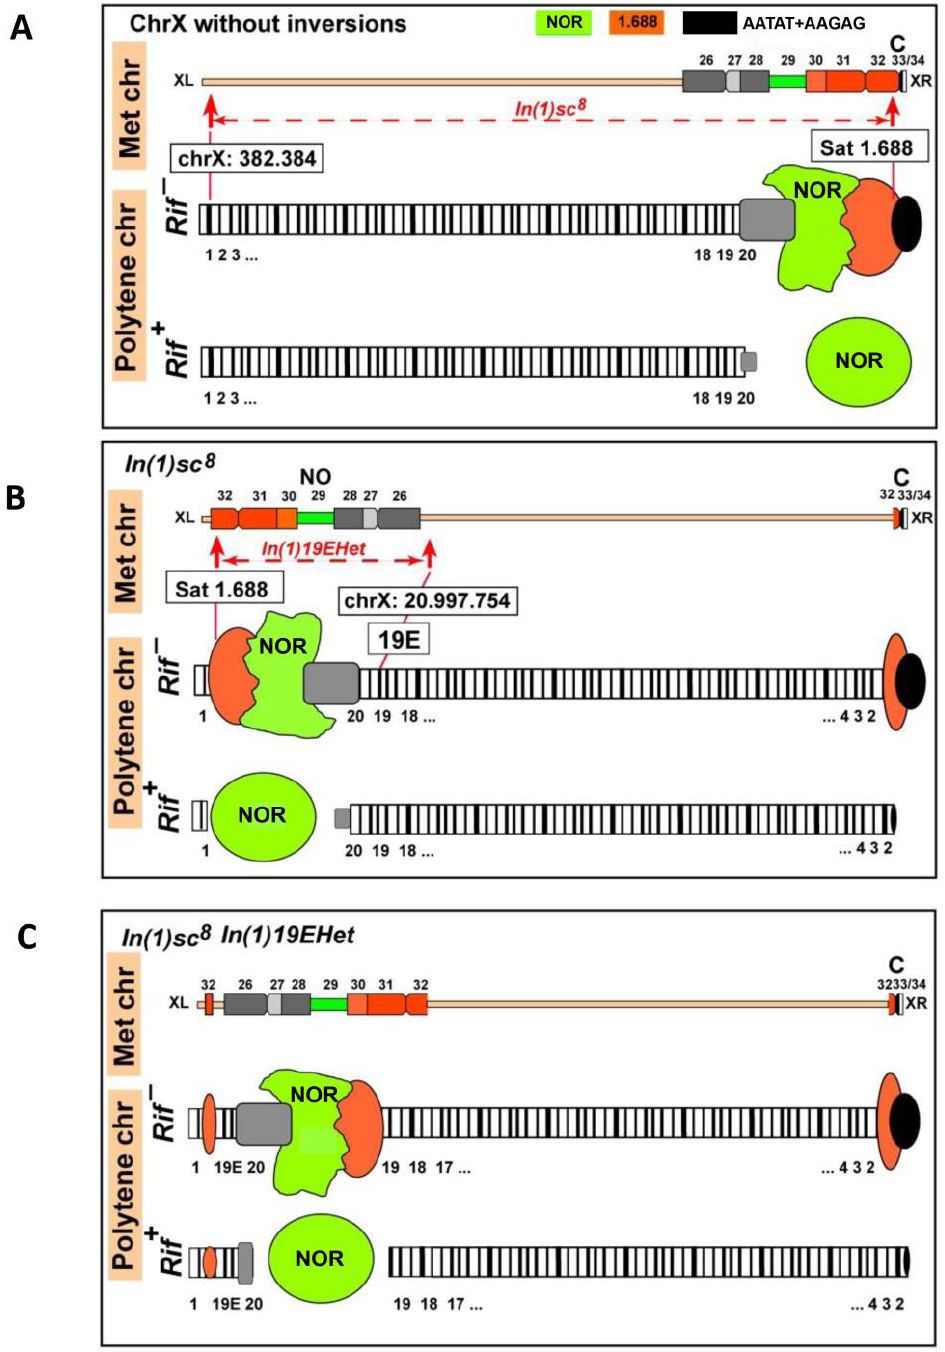
Figure 2. Schematic representation of metaphase and polytene X chromosomes without inversions ( A ), with In(1)sc 8 ( B ) and with both In(1)sc 8 and In(1)19EHet inversions ( C ). Schemes of polytene chromosomes are given for the Rif1 + and Rif1 - backgrounds. Positions of In(1)sc 8 and In(1)19EHet breakpoints are marked by arrows on chromosomes that are not rearranged. Blocks of heterochromatin are indicated according to the classical map of metaphase chromosomes [7]. The colours of the 28 S rDNA and 1.688 satellite reflect the colours of FISH probes in Figure 1B. The regions affected by the new rearrangement are largely under-replicated in wild-type polytene chromosomes, and therefore, the In(1)19Ehet inversion could not be detected without the Rif1 1 background.